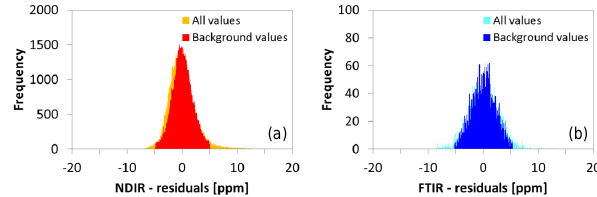
Figure 3. (a) Histogram of all NDIR residuals (yellow) and the fil- tered NDIR residuals representing the background values (red) of the in situ measurements; (b) histogram of all FTIR residuals (light blue) and the filtered FTIR residuals representing the background values (blue) of the column.